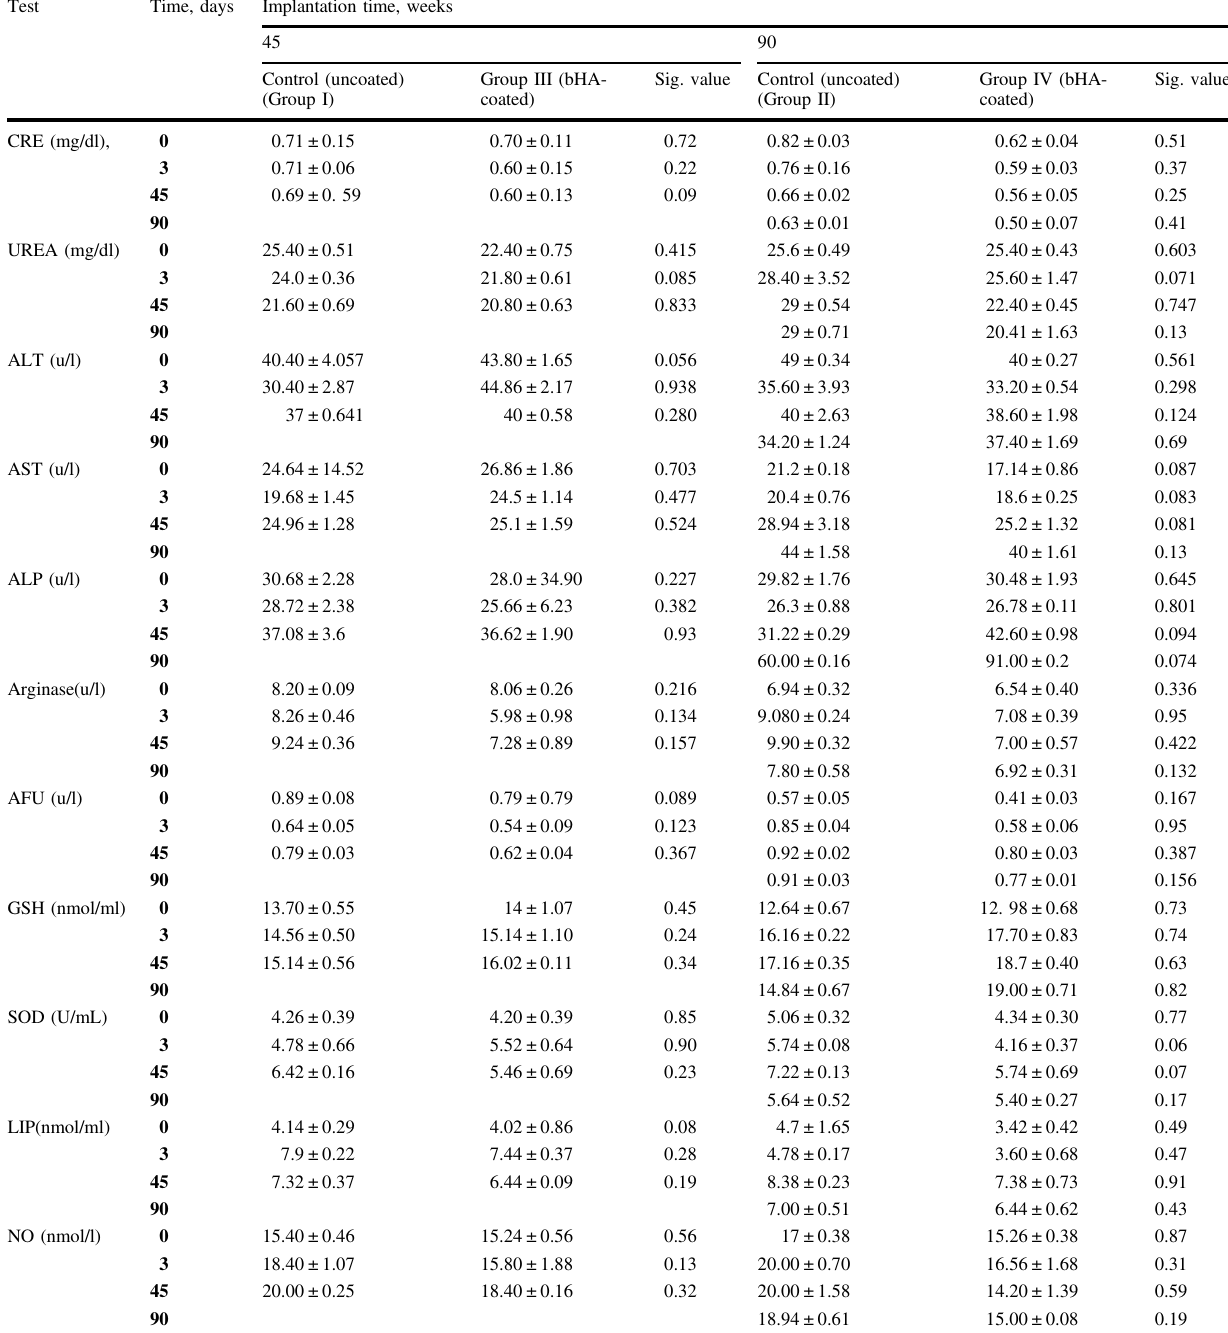
Table 1 Serum CRE and serum urea levels (mg/dl), ALT, AST, and ALP levels (U/L), arginase (U/L), AFU (U/L), and GSH, SOD (U/mL), LIP (nmol/mL), and NO (nmol/L) of the treated group dogs (bHA-coated) (Groups III and IV) compared with the control group (uncoated) dogs (Groups I and II) at T0 (immediately post surgery) and at 3, 45, and 90 days post surgery